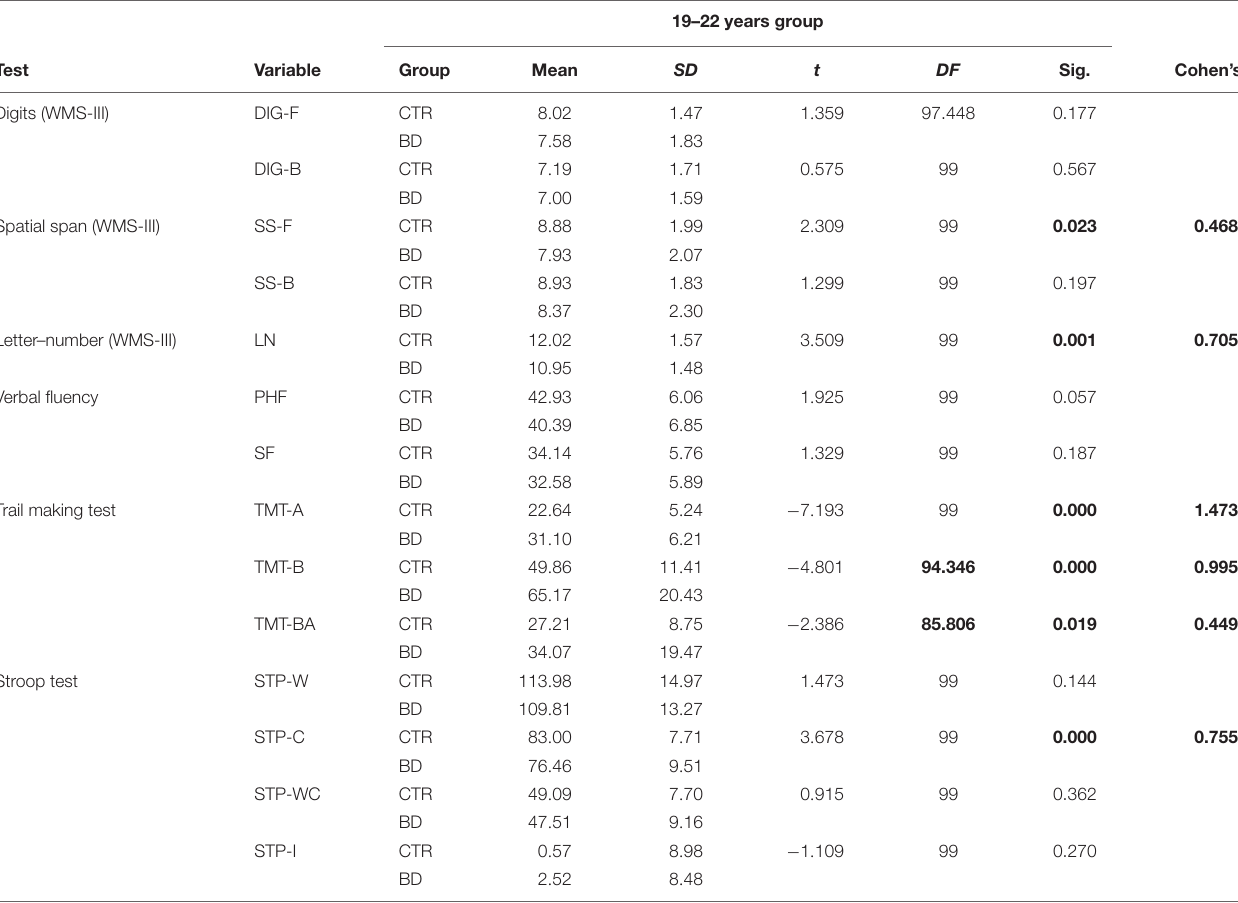
TABLE 5 | Mean differences between BD and control groups of 19–22-year-old